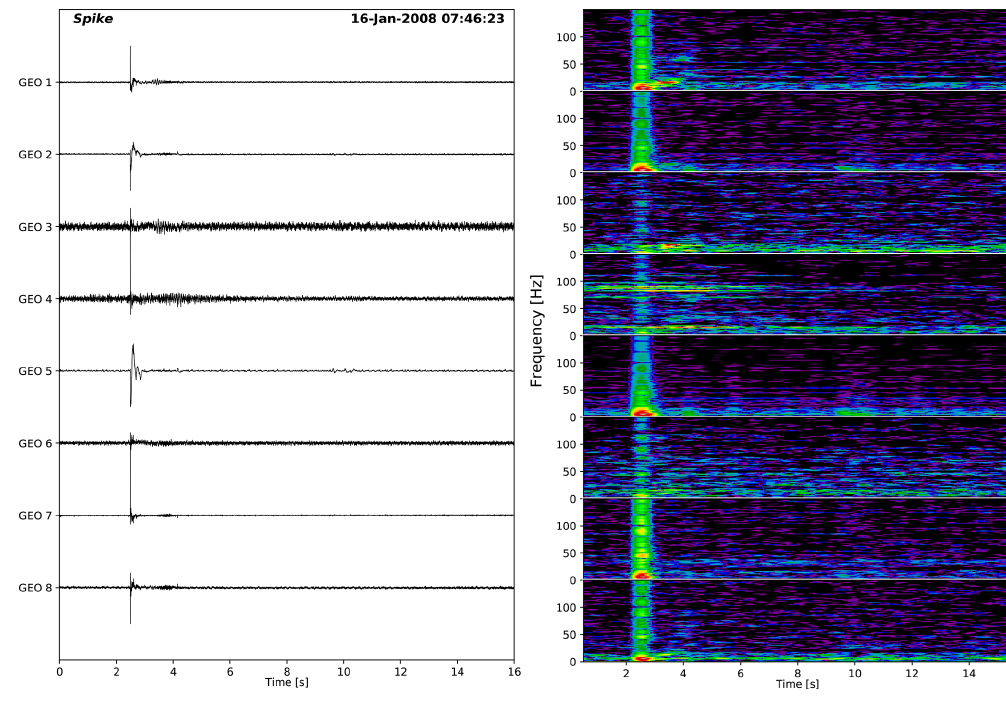
Figure B7. Example of an electric spike.